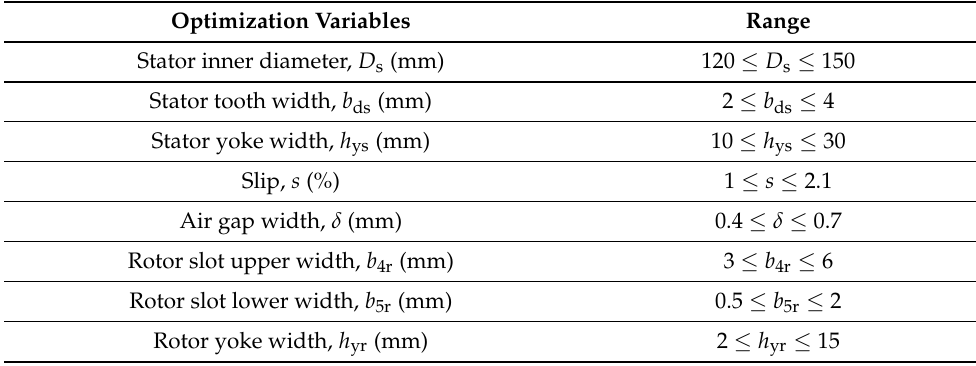
Table 3. Optimization variables and their